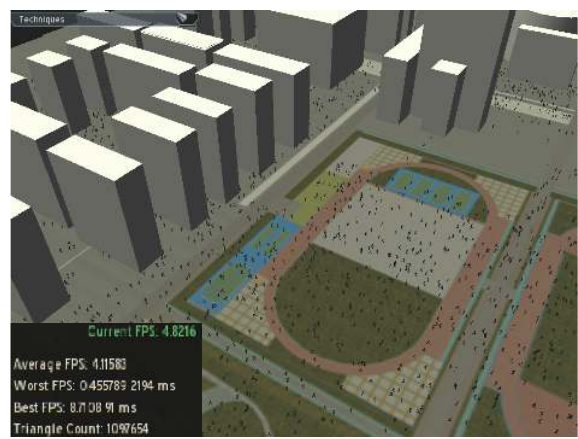
Fig. 8 Close-up of the stadium in the CESS.